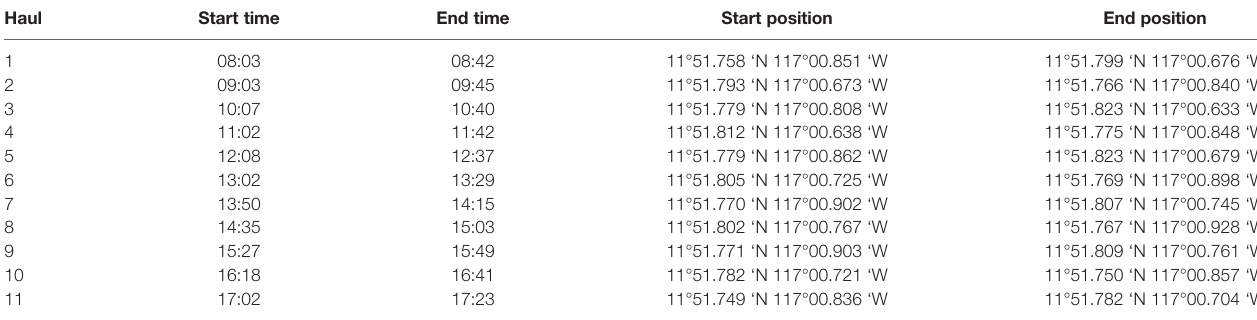
TABLE 1 | Dredge times (UTC) and positions (longitude, latitude) of each haul on the 11 th of April